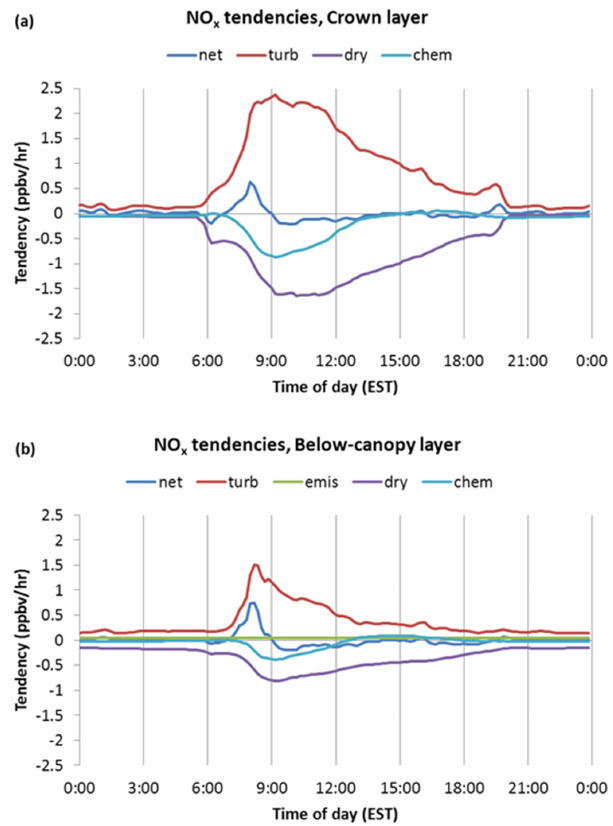
Fig. 11. Simulated August mean diurnal cycle in NO x process ten- dencies (ppbvh − 1 ) of emissions (red solid line), dry deposition (green long-dashed line), chemistry (blue short-dashed line), tur- bulent transport (maroon dashed line), and the net tendency (black solid line) (a) in the crown layer and (b) in the understory layer. primarily by turbulent transport and dry deposition (Fig. 11).